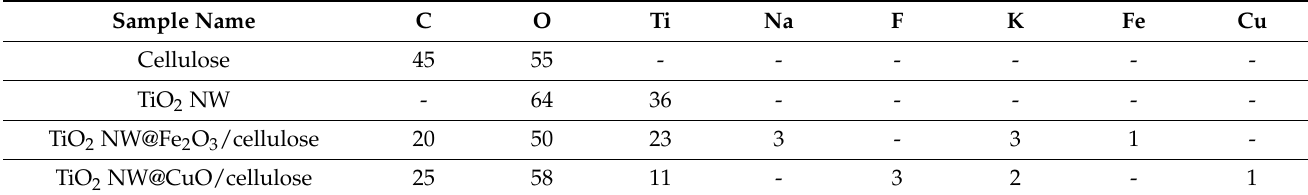
Table 1. Elemental (EDS) analysis of the raw materials (cellulose and TiO 2 NW) and hybrid membranes.